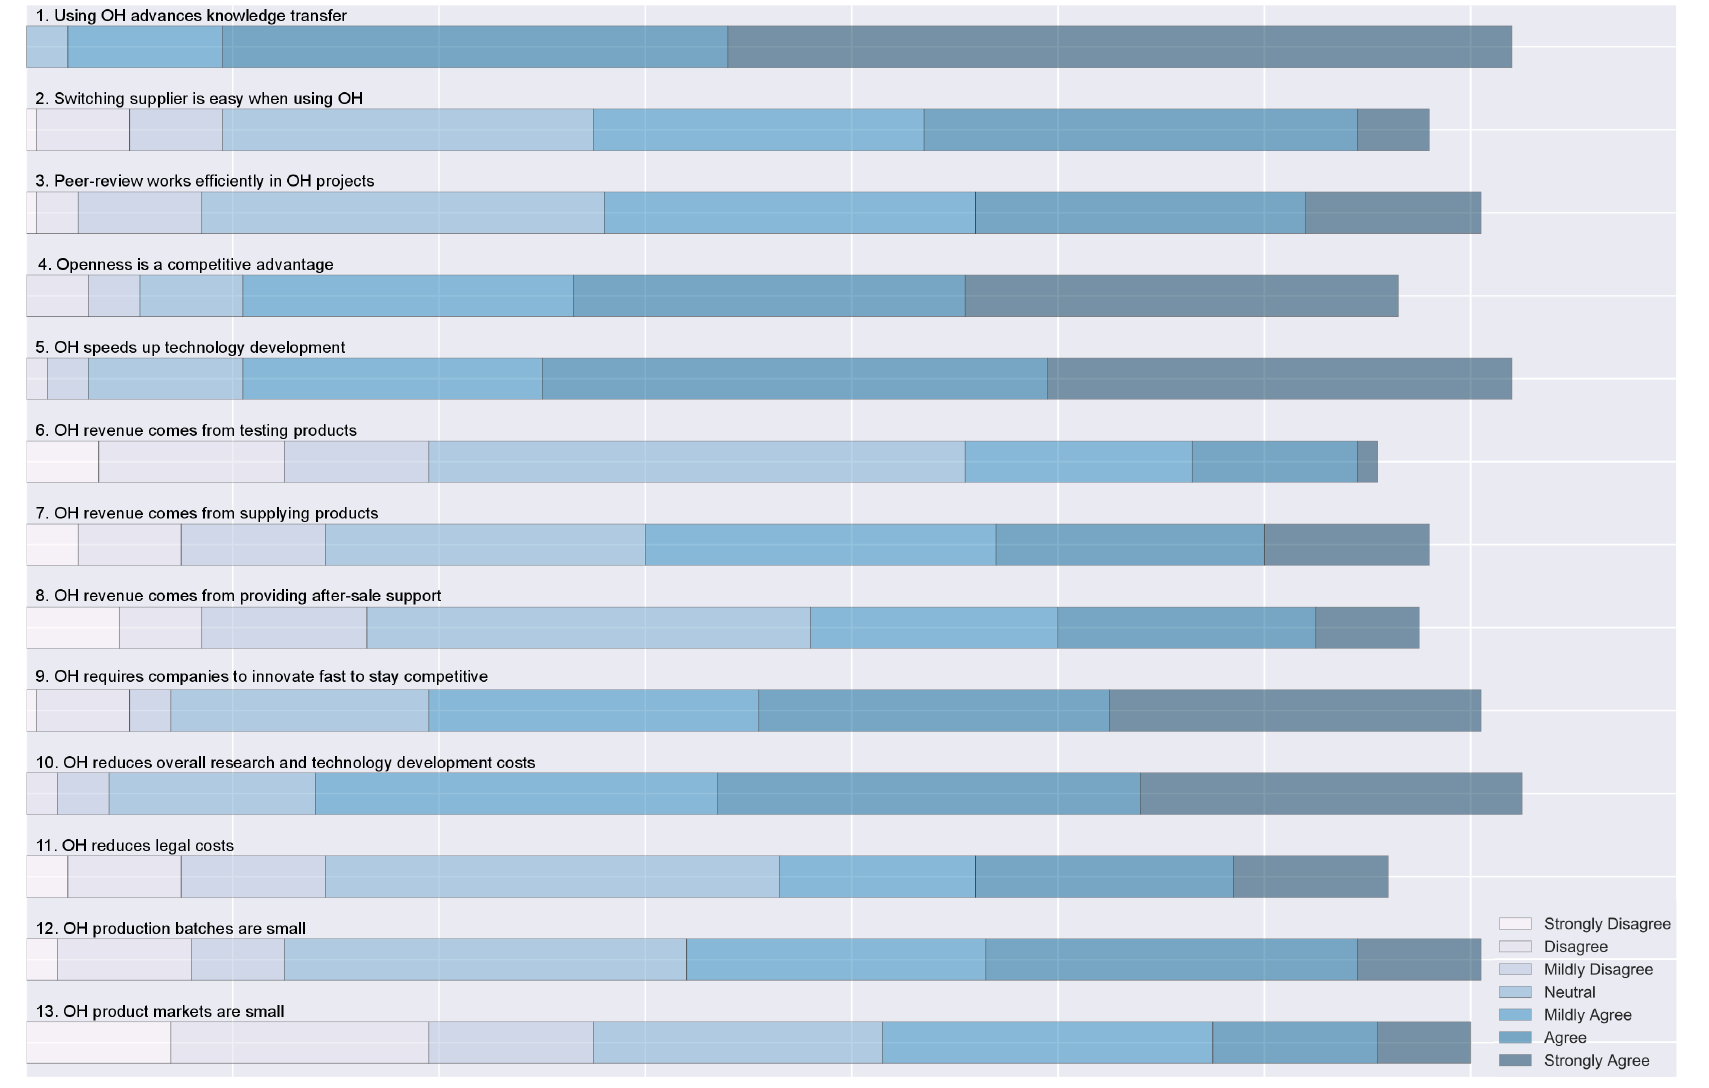
Figure 2a: Respondents' perceptions of common open hardware